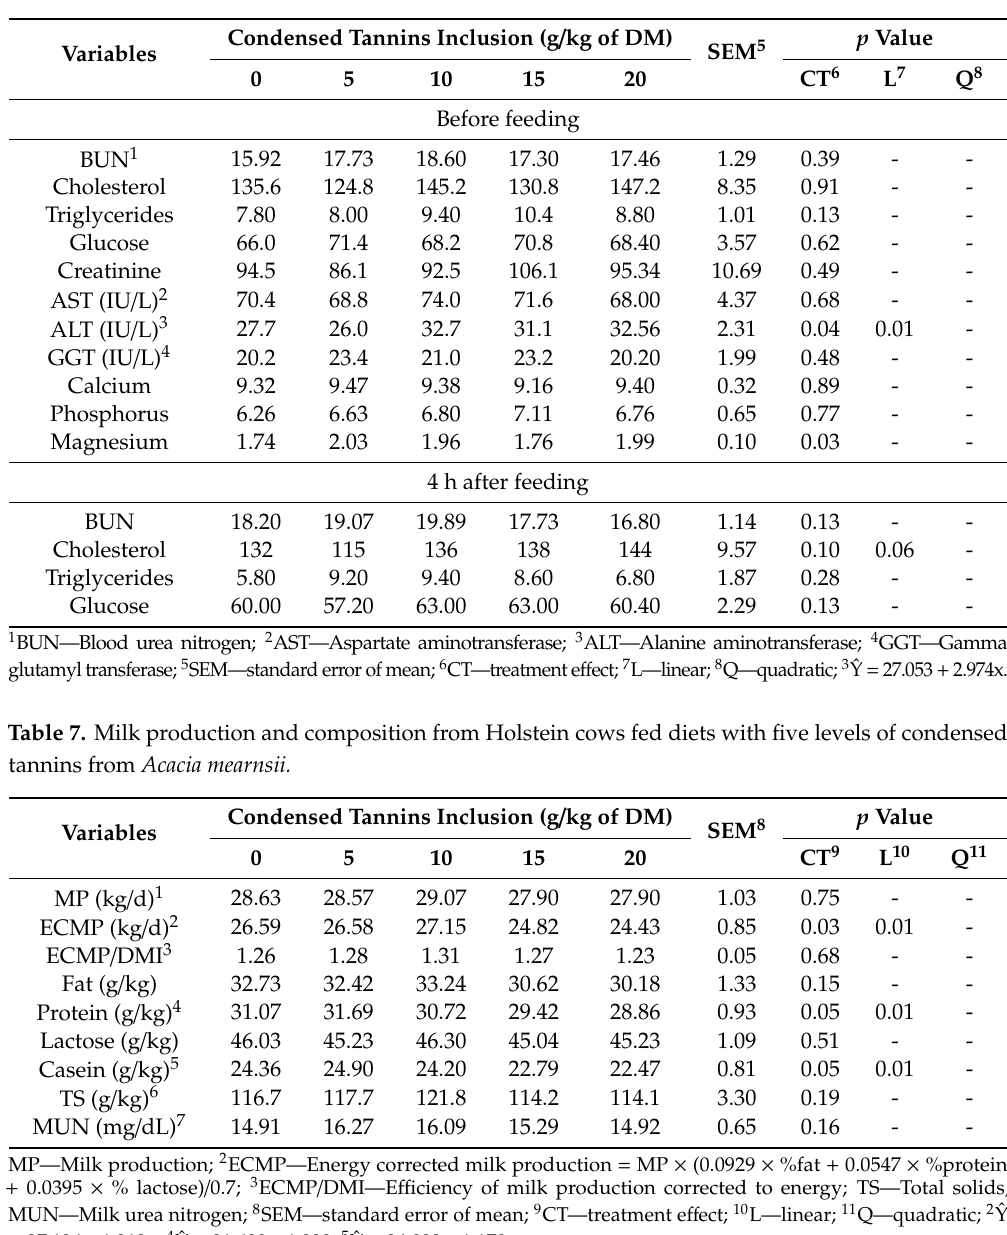
Table 6. Blood parameters (mg / dL) of Holstein cows fed diets with five levels of condensed tannins from Acacia mearnsii.